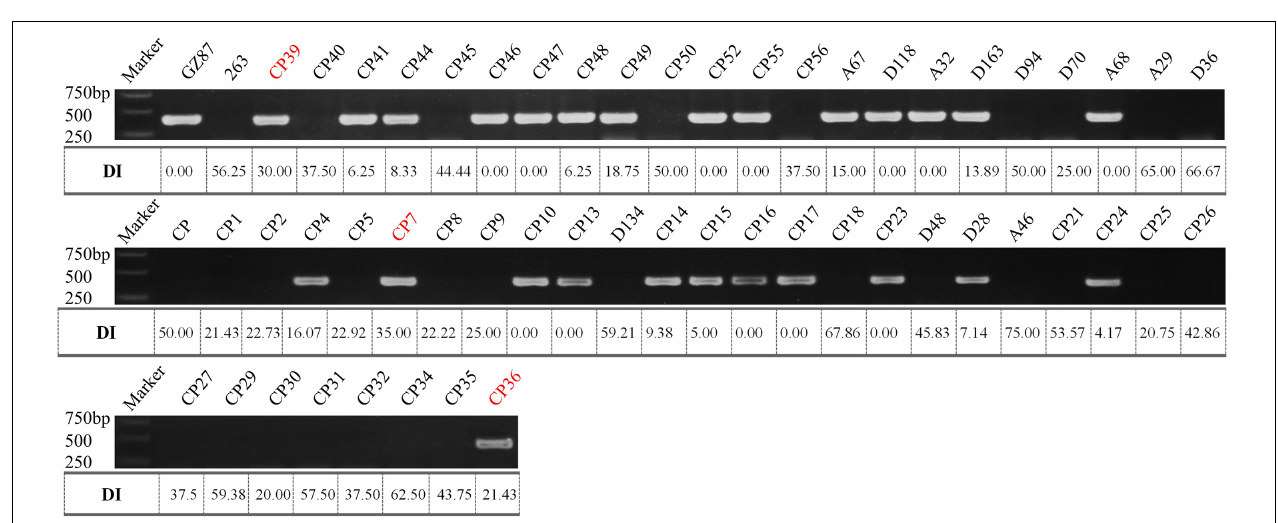
FIGURE 5 | The PCR amplification of SWU-OA in two parents and F2 lines. Mismatches between the PCR products and the DI values were indicated in